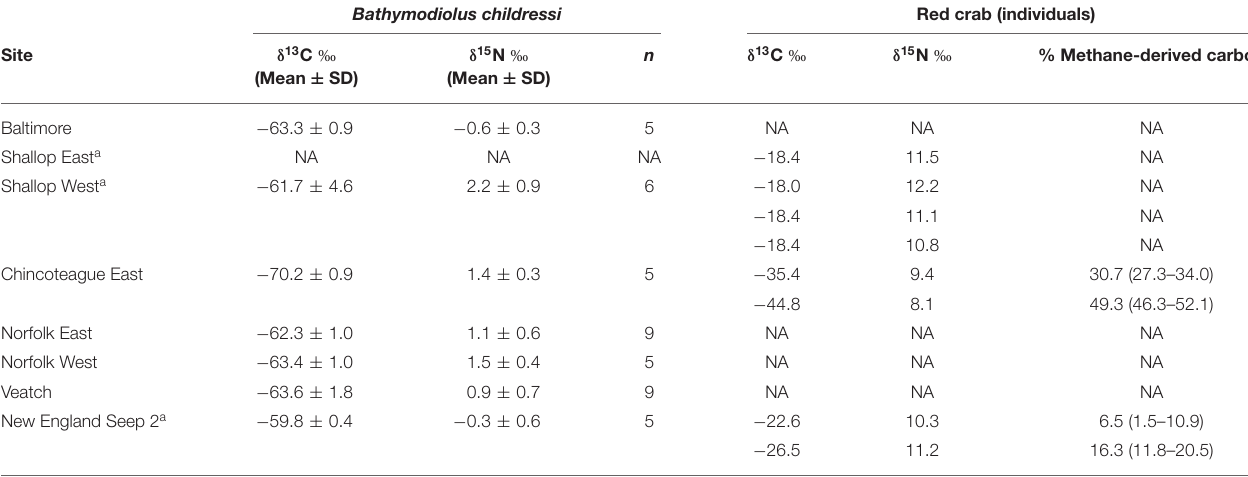
TABLE 4 | Stable isotope ( δ 13 C and δ 15 N) data for samples of bathymodiolin mussel ( Bathymodiolus childressi ) and red crab ( Chaceon quinquedens ). Bathymodiolus childressi